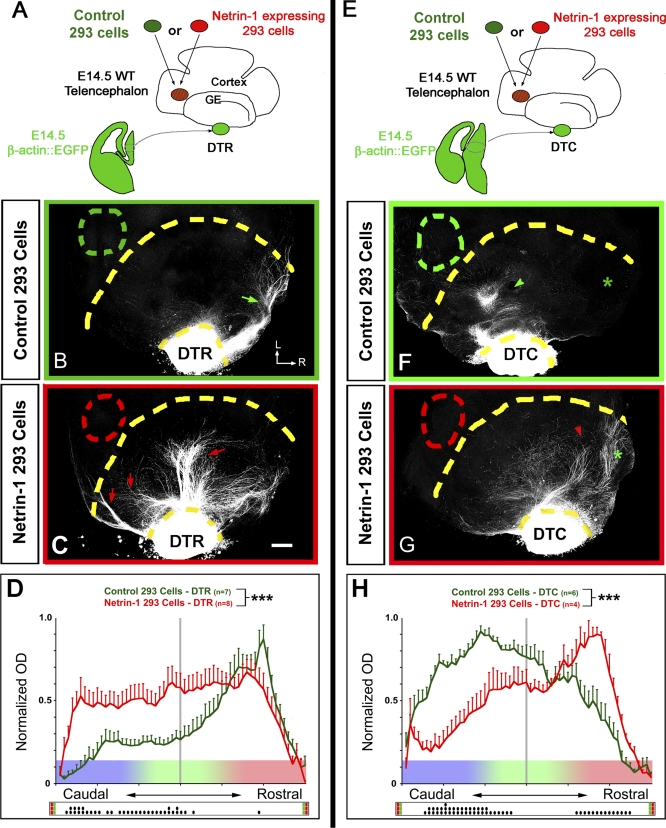
Netrin-1 Is Acting as a Chemoattractive Cue for Rostral Thalamic Axons and a Chemorepulsive Cue for Caudal Thalamic Axons(A and E) Experimental paradigm: control 293 cells (B and F) or 293 cells stably expressing Netrin-1 and embedded in collagen (C and G) were grafted in proximity of the caudal part of the VTel of E14.5 wild-type whole-mount telencephalon cocultured with EGFP-expressing explants isolated from isochronic rostral DTh (DTR; [B and C]) or caudal DTh (DTC; [F and G]).(B and C) Axons originating from the rostral DTh grow rostrally in the VTel of telencephalic whole mount grafted with control 293 cells in the caudal VTel (green arrow in [B]). In contrast, a significant proportion of DTR axons project caudally when Netrin-1–expressing cells are grafted in the caudal VTel (red arrows in [C]). L, lateral; R, rostral.(D) Quantification of normalized optical density (OD) of DTR-EGFP axons growing in VTel grafted caudally with control 293 cells (green) or VTel grafted caudally with Netrin-1–expressing 293 cells (red).(F and G) Axons originating from the caudal DTh grow caudally in the VTel of a telencephalic whole mount with control 293 cells grafted in the caudal VTel (green arrowheads in [F]). In contrast, a significant proportion of DTC axons grow rostrally when Netrin-1–expressing cells are grafted in the caudal VTel (red arrowhead in [G]).(H) Quantification of normalized optical density (OD) of DTC-EGFP axons growing in VTel with control 293 cells grafted caudally (green) or VTel with Netrin-1–expressing 293 cells grafted caudally (red). Significantly more DTC axons grow to the rostral part of the VTel grafted with Netrin-1–expressing cells than in control graft. Triple asterisks (***) indicate p < 0.001, ANOVA one-way test (overall effect: bins versus experimental conditions). The raster-like dot plot presented under each histogram (D and H) represents the significance of individual bins comparisons performed between the two experimental conditions according to a Fisher PLSD post hoc test (a single dot [•] indicates p < 0.05; double dots [••] indicate p < 0.01; and triple dots [•••] indicate p < 0.001).Scale bars in (B, C, F, and G) represent 150 μm.